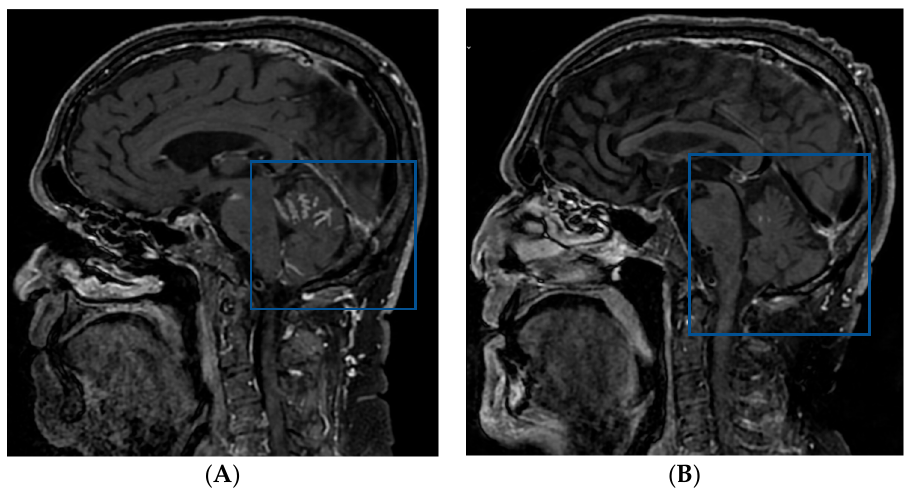
Figure 4. MRI scan prior to rechallenge with EV ( A ) and after two months ( B ). A significant reduction can be seen (squared boxes) of the initial meningeal carcinomatous infiltration of the posterior fossa and base of the skull. Abbreviations: EV, enfortumab vedotin; MRI, magnetic resonance imaging.